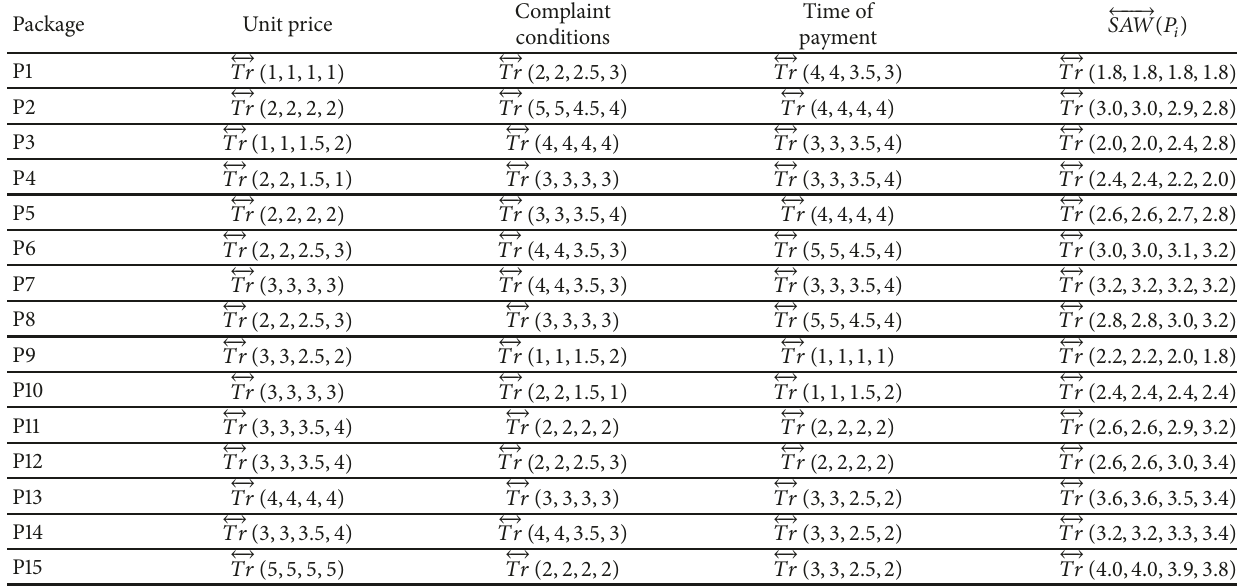
Table 4: Numerical evaluation of negotiation packages.